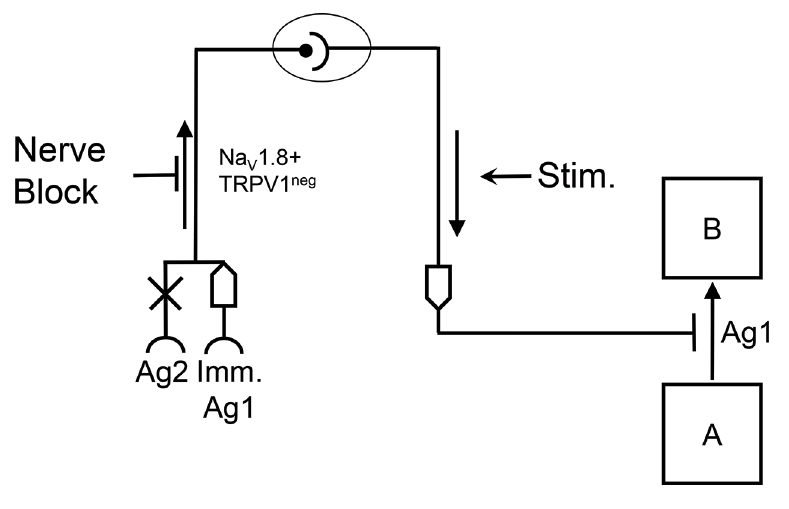
Figure 6. A model diagram depicting the antigen-restriction reflex. A neuronal pathway distinguishes between novel and immunized antigens, sending a nerve signal through Na + ve, TRPV1 neg neurons, which is transmuted into a motor signal leading to restriction of anti- gen flow from lymph node A to lymph node B (e.g., popliteal to sciatic lymph